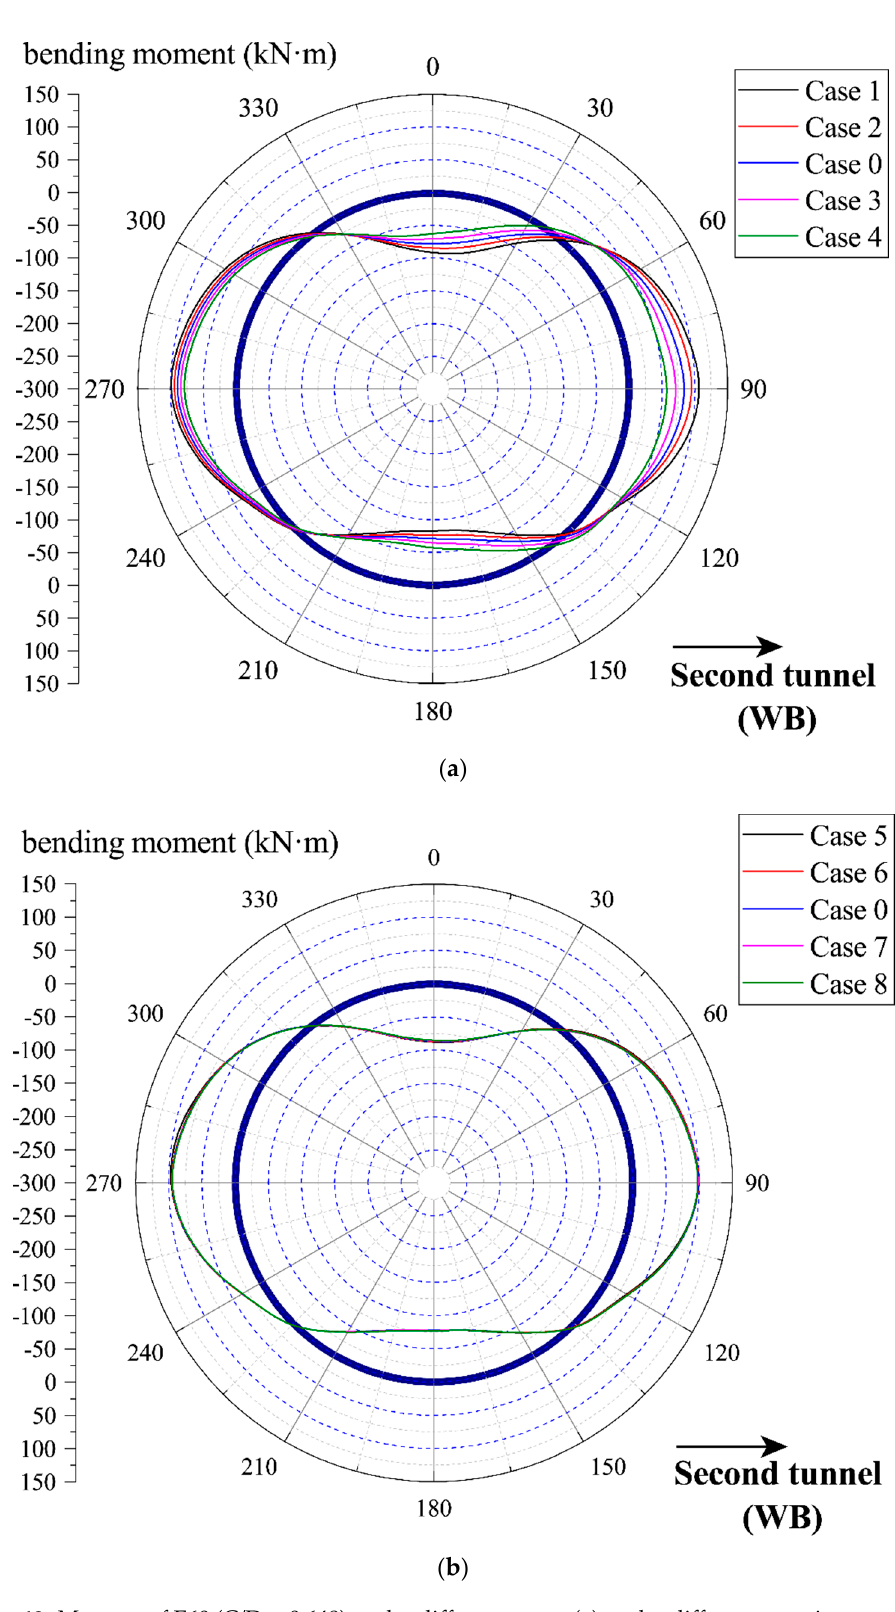
Figure 13. Moment of E60 (C/D = 0.648) under different cases: ( a ) under different grouting pressures; ( b ) under different supporting pressures.